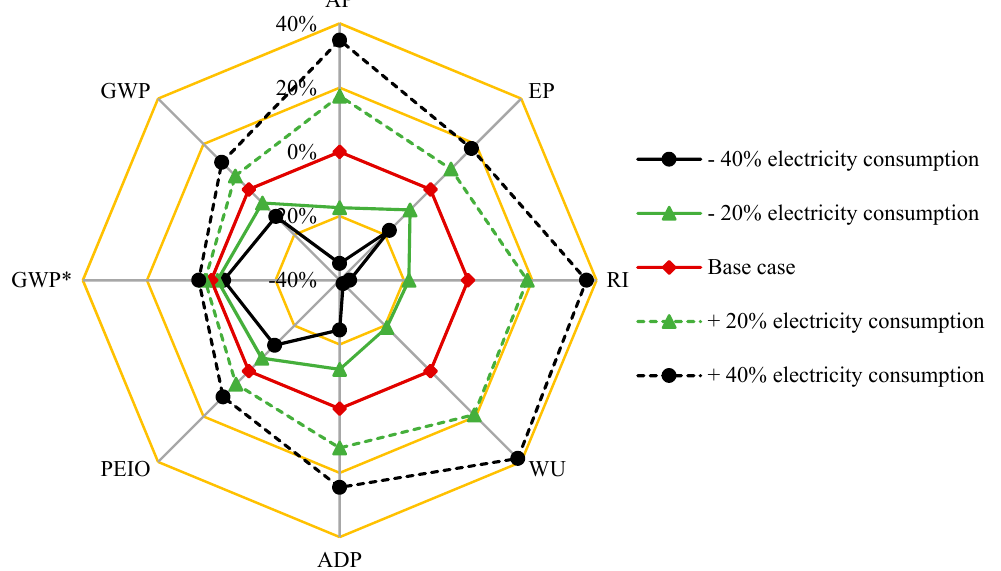
Figure 3. Results of sensitivity analysis for the effect of electricity consumption on global warming potential (GWP), acidification potential (AP), eutrophication potential (EP), respiratory inorganics (RI), water use (WU), abiotic depletion potential (ADP), primary energy input to output ratio (PEIO) and CH 4 emission from anaerobic digestion on GWP (GWP*).